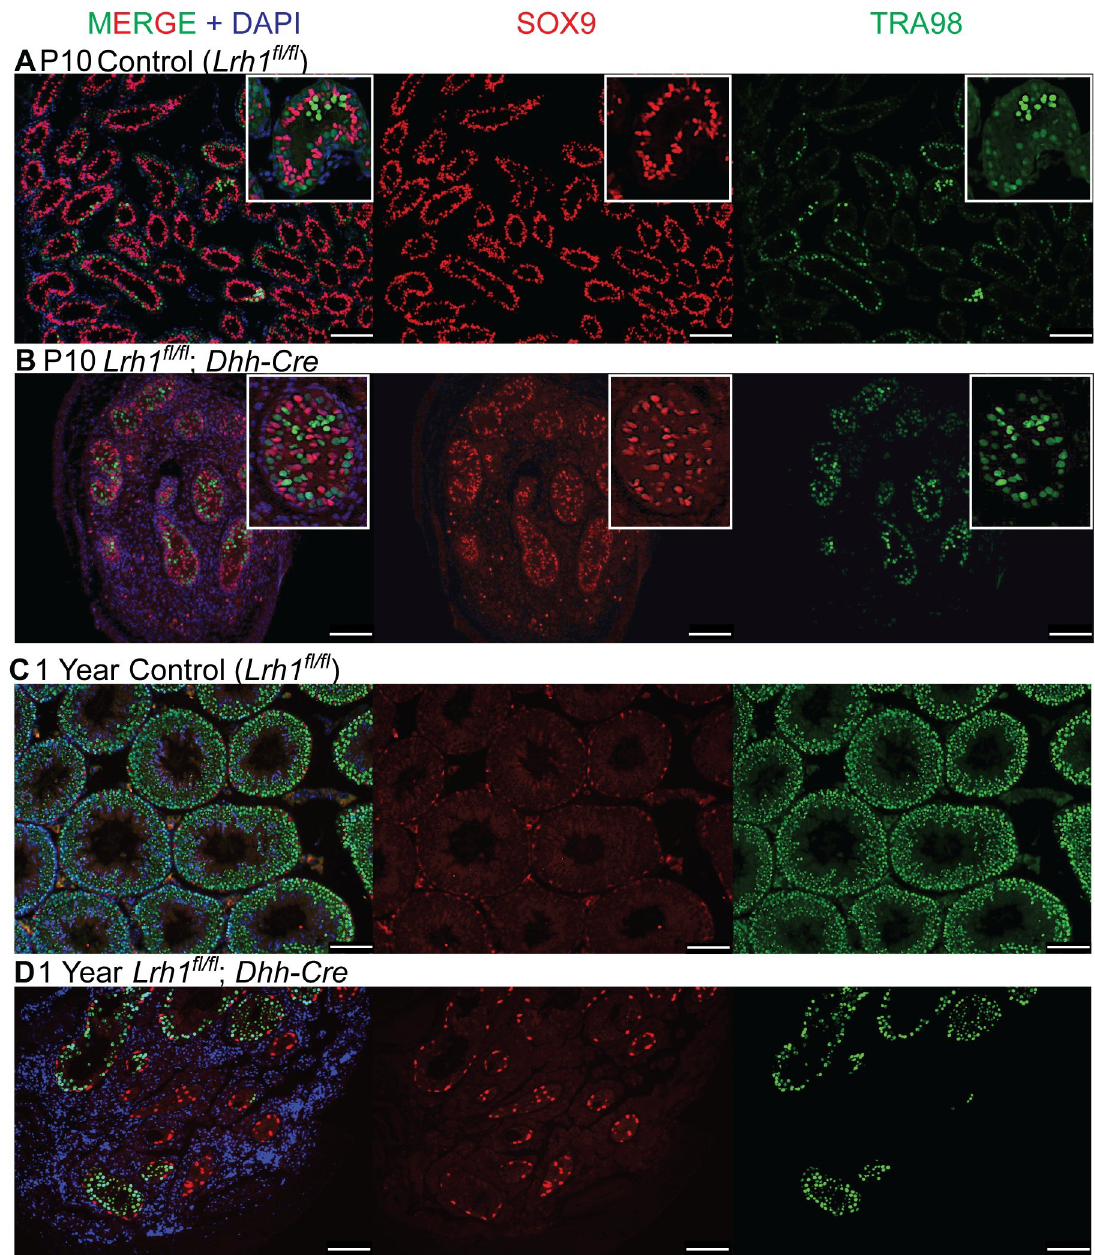
Fig 8. Lrh1 is required in Sertoli cells for sustained and robust spermatogenesis. IF of control and Dhh-Cre deleted Sertoli-specific Lrh1 conditional mutant testis sections stained for SOX9 (red), TRA98 (green) and DNA (DAPI, blue). (A,B) P10 testes, showing reduced testis size and disorganized tubules; (C,D) one year testes, showing presence of presence and absence of spermatogenesis in disorganized tubules. Scale bars: 100